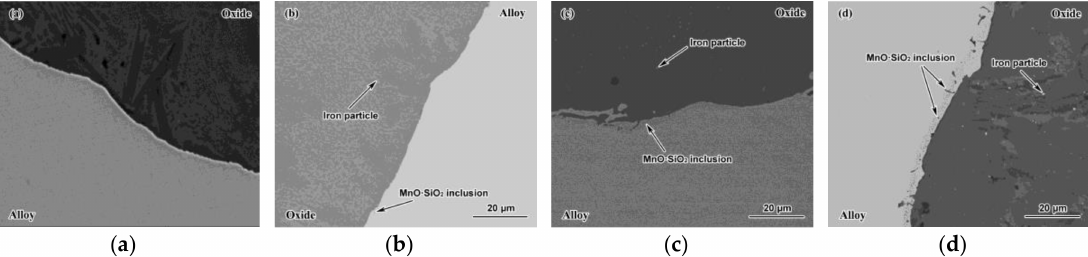
Figure 4. Morphologies of the interfaces between the Fe–Mn–Si alloy and CaO–SiO 2 –Al 2 O 3 – MgO–MnO–FeO oxide in the A-1- x diffusion couples after isothermal heating at 1273 K for 10 h: ( a ) A-1-0; ( b ) A-1-1; ( c ) A-1-2; ( d )